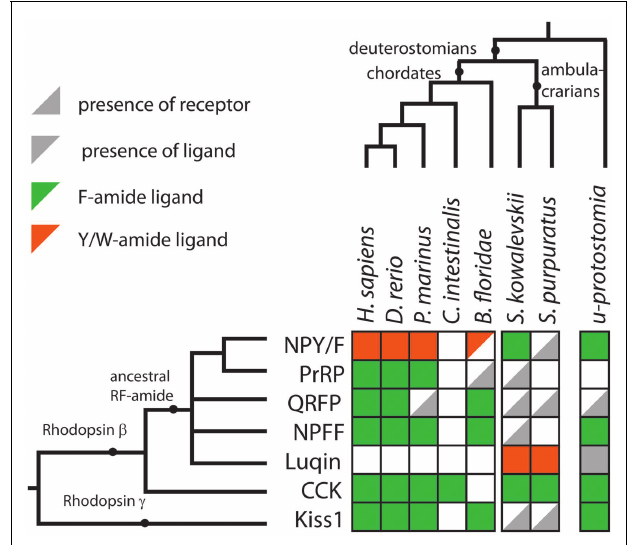
FIGURE 4 | Summary of RFamide-type peptides and receptors that have been identified in representative deuterostomian taxa . A gray triangle in the bottom right indicates that a receptor has been identified but a candidate ligand has not yet been identified. A gray triangle in the top left indicates that a peptide(s) has been identified but a candidate cognate receptor has not yet been identified. An empty white square indicates that neither a receptor nor a candidate peptide has been identified.The color of the triangle indicates that the peptide is either a Phe-amide (Fa, green), a Tyr-amide, orTrp-amide (Y/Wa, orange) or unknown (gray) in a given species or group of species.The last column of squares to the right describes the expected situation in the last common ancestral protostomian ( u-protostomia ). A supplementary table provides further details of IDs for the sequence data used to compile this